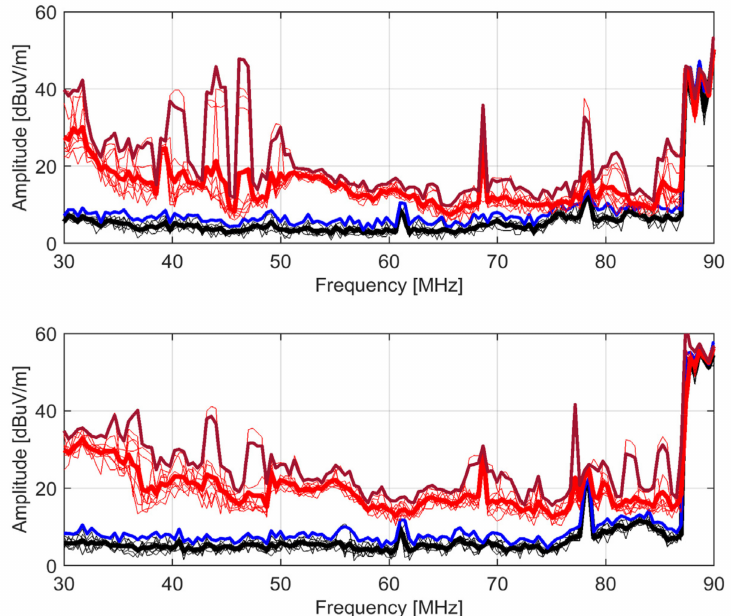
Figure 6. E-field intensity measured for qualification of a trolley bus (frequency interval limited to 30 to 90 MHz for displaying purpose): background (data black, mean thick black, +1 σ profile blue) and emissions in simulated run (data red, mean thick red, +1 σ profile brown). Note: “simulated run” refers to the trolley bus unit propped up on suspending tripods and wheels running